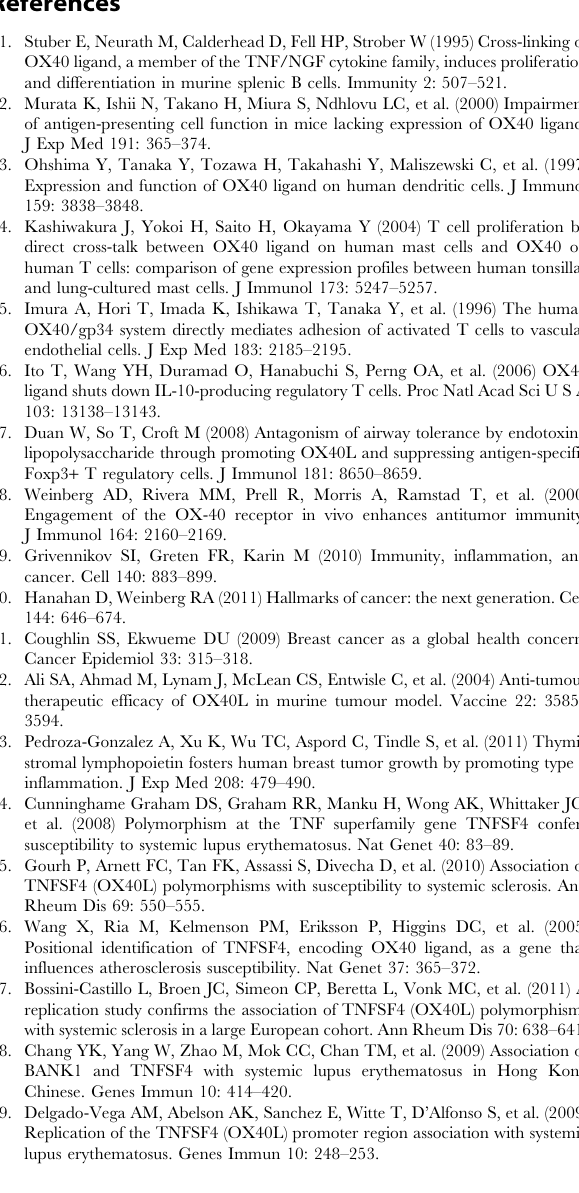
Table S3 Information of primers and